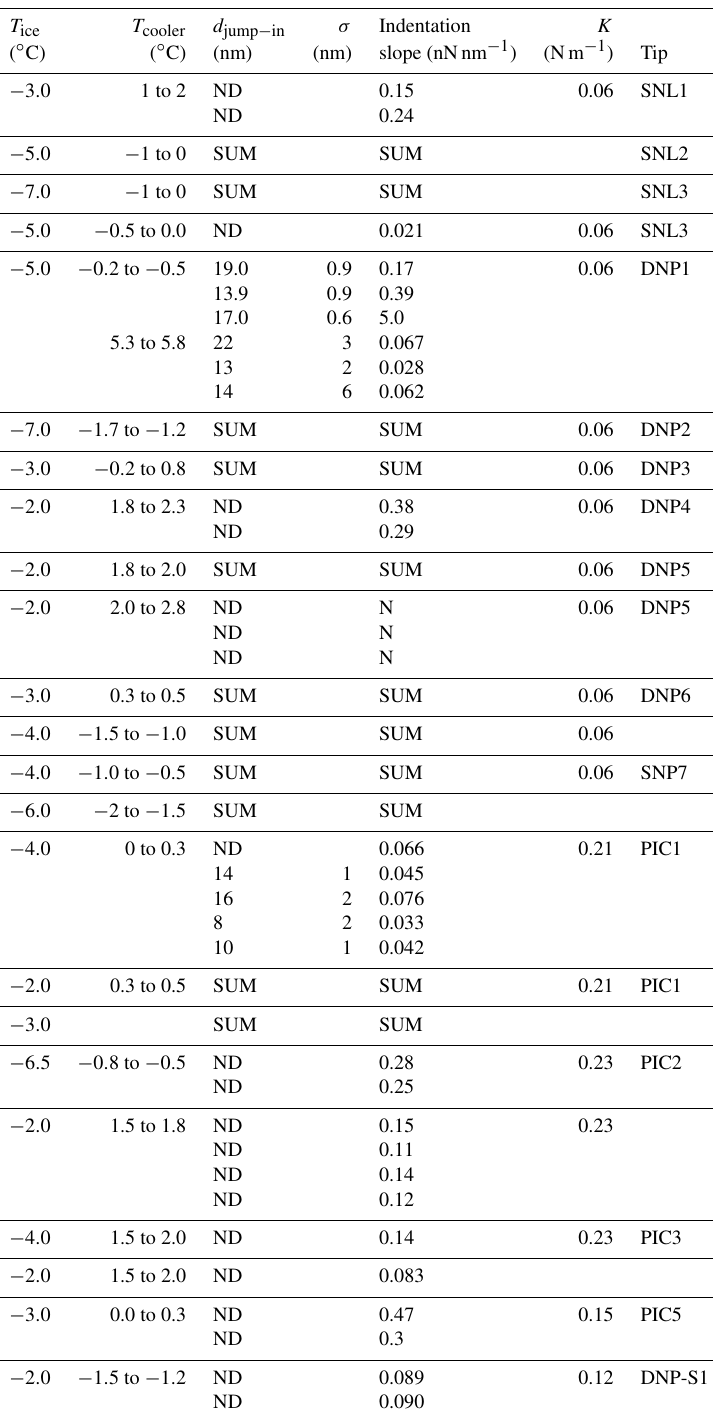
Table 2. Average jump-in distances (and their dispersions, σ) obtained from AFM force curves over ice with the mEC for different tips (see the Supplement). The numbers of the tips correspond to different tips of equal characteristics, while different rows at the same T cooler represent force curves measured on different positions over the ice surface. The indentation slopes corresponding to the first 50nm and the spring constant for the cantilevers at the different studied temperatures are also